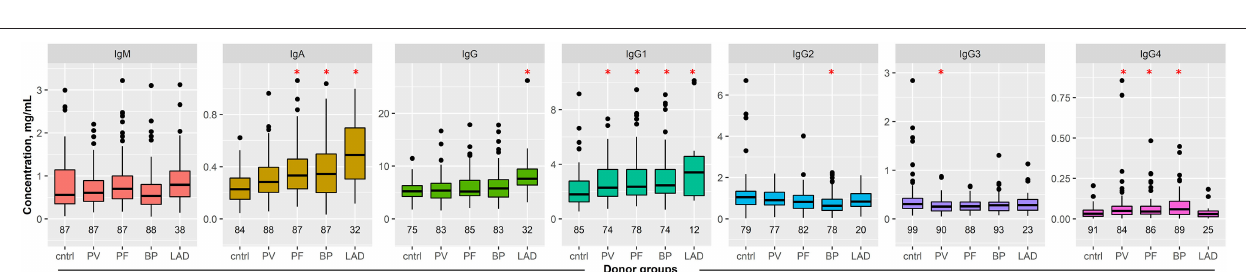
FIGURE 2 | Serum immunoglobulin (Ig) concentrations in patients with pemphigus and pemphigoid disease. Serum concentration of IgM, IgA, IgG, and IgG1–4 were determined in healthy blood donors and patients with the indicated pemphigus and pemphigoid diseases by ELISA. The numbers below the boxes indicate the number of controls/patients included in each group. Data are shown as median (black line) and 25/75 percentiles (boxes); the whiskers extend no further than 1.5 × IQR from a hinge (where IQR is the interquartile range) and outliers (points). ANOVA with Tukey’s HSD procedure as post-hoc test was used for statistical analysis. *indicates p < 0.05 compared to